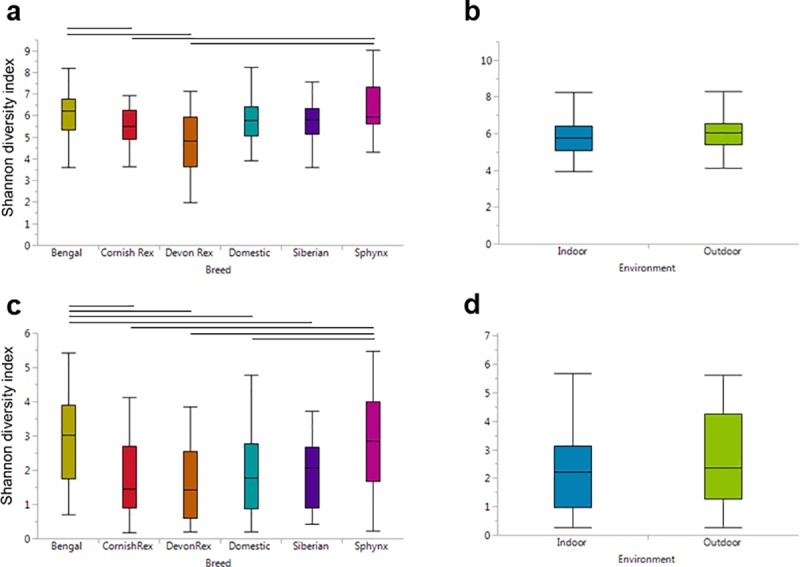
Comparing alpha diversity as measured by the Shannon diversity index between cat breeds and indoor and outdoor cats.Comparing alpha diversity of (a) bacterial communities between cat breeds (p<0.0001), (b) bacterial communities between indoor and outdoor cats (p = 0.2509), (c) fungal communities between cat breeds (p<0.0001), and (d) fungal communities between indoor and outdoor cats (p = 0.8340) using the Shannon diversity metric. Lines show significant pairwise tests where p<0.01. Sample sizes (bacterial sequencing, fungal sequencing): Bengal (54, 54), Cornish Rex (45, 45), Devon Rex(19, 19), Domestic/Indoor (55, 59), Siberian (29, 30), Sphynx (70, 69), and Outdoor (60, 58).